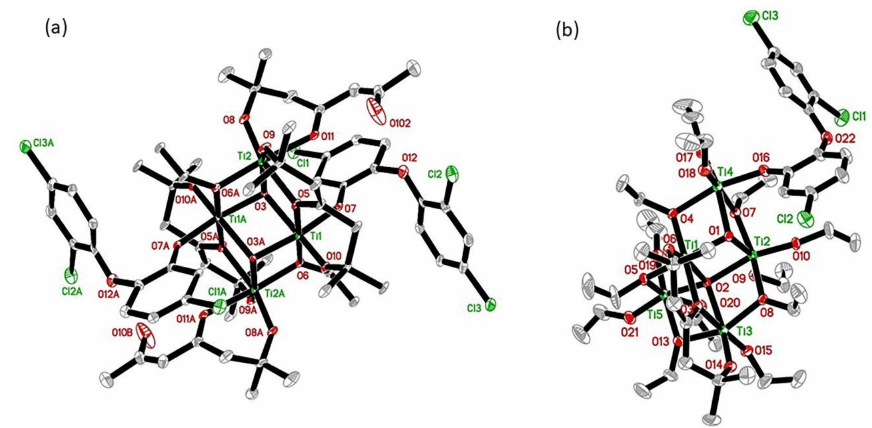
Figure 4. Molecular structure of compound 1 ( a ) and molecular structure of compound 2 ( b ).